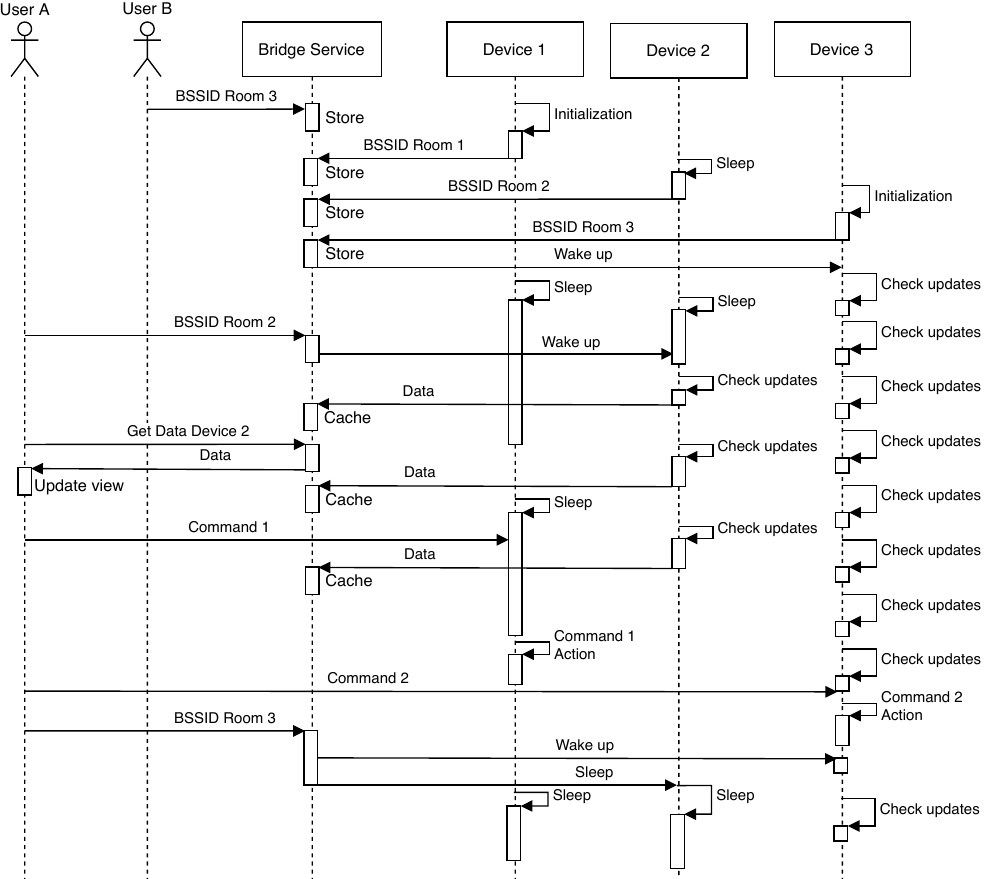
Figure 3. Sequence diagram of a low-power system built on top of the